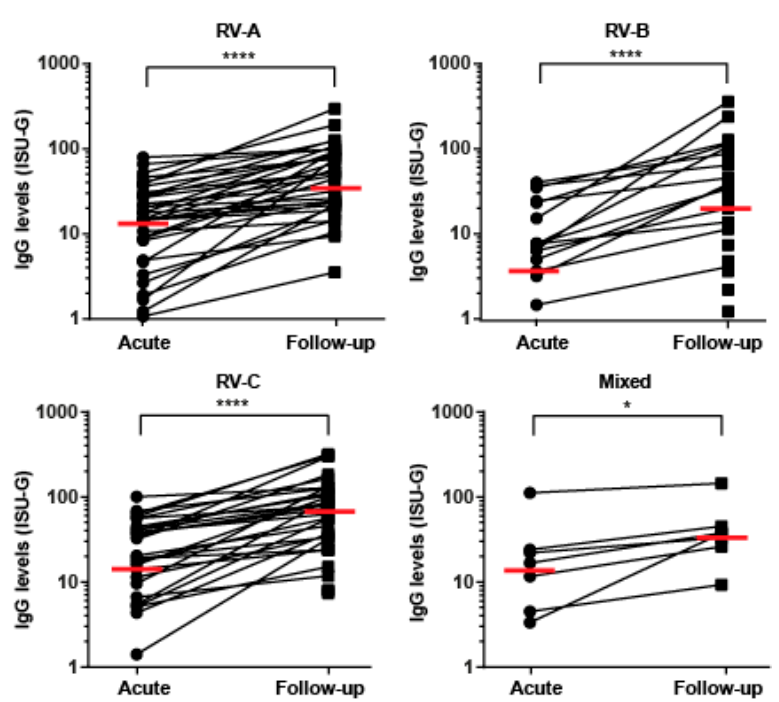
Figure 1. Increases in RV species-specific antibody responses in preschool children presenting with acute wheeze. ( A ) Pie chart showing percentages of children ( n = 120) with increases in IgG antibodies specific to VP1-derived peptides representing the three RV species (red: RV-A; blue: RV-C; green: RV-B; yellow: mixed RV species; grey: no RV-specific responses). ( B ) Levels of RV-specific IgG antibodies (y-axes: ISU-G) measured during the acute and the follow-up visits (x-axes) in children for which RV-A ( n = 41), RV-B ( n = 23), RV-C ( n = 33), and mixed RV ( n = 7) were identified as culprit RV species. IgG responses to the peptide with the largest IgG increase are shown, where horizontal bars represent median values of RV-specific IgG levels. Statistically significant differences between subjects were calculated via the Wilcoxon matched-pairs signed rank test, and they are indicated on the graphs (**** p < 0.0001; * p < 0.05).